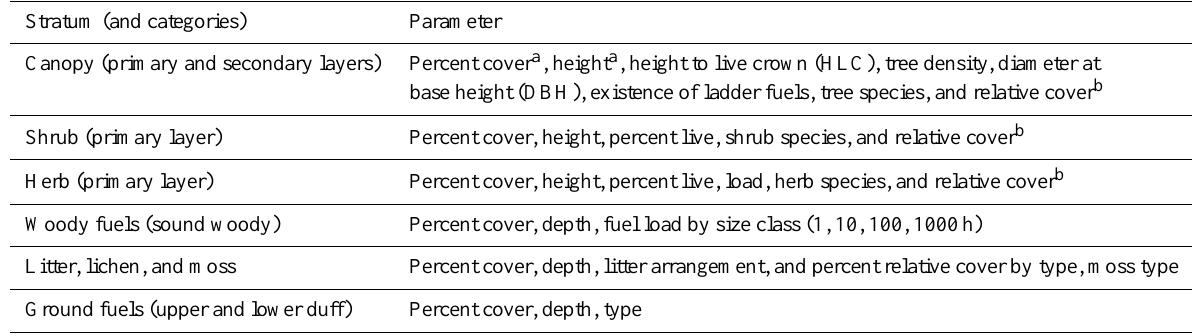
Table 1. Parameters assigned to each fuelbed. Stratum (and categories)